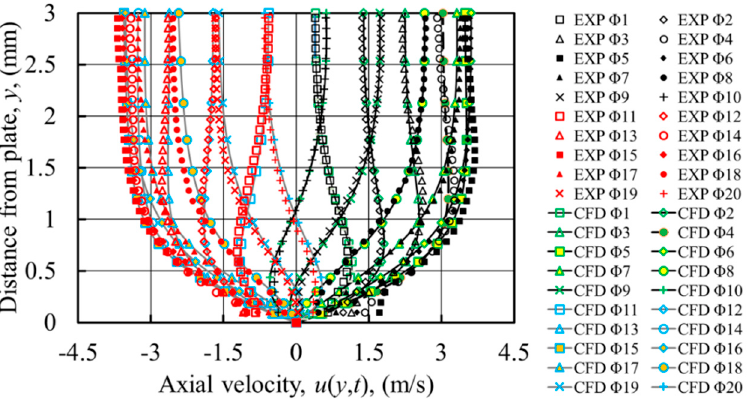
Figure 11. Velocity profiles from the SST k- ω model (black and grey lines) and experiment (red and black symbols). Plotted for the location 10 mm from the joint, inside the cold channel, for the 0.83% drive ratio.